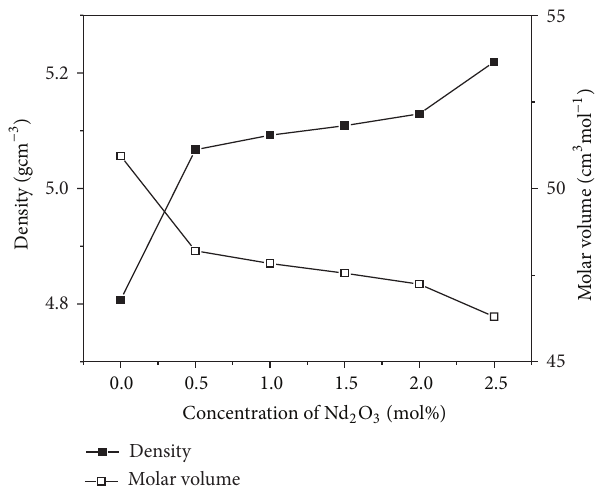
Figure 1: Density and molar volume of Nd 3+ doped Bi 2 O 3 –BaO– B 2 O 3 glasses.